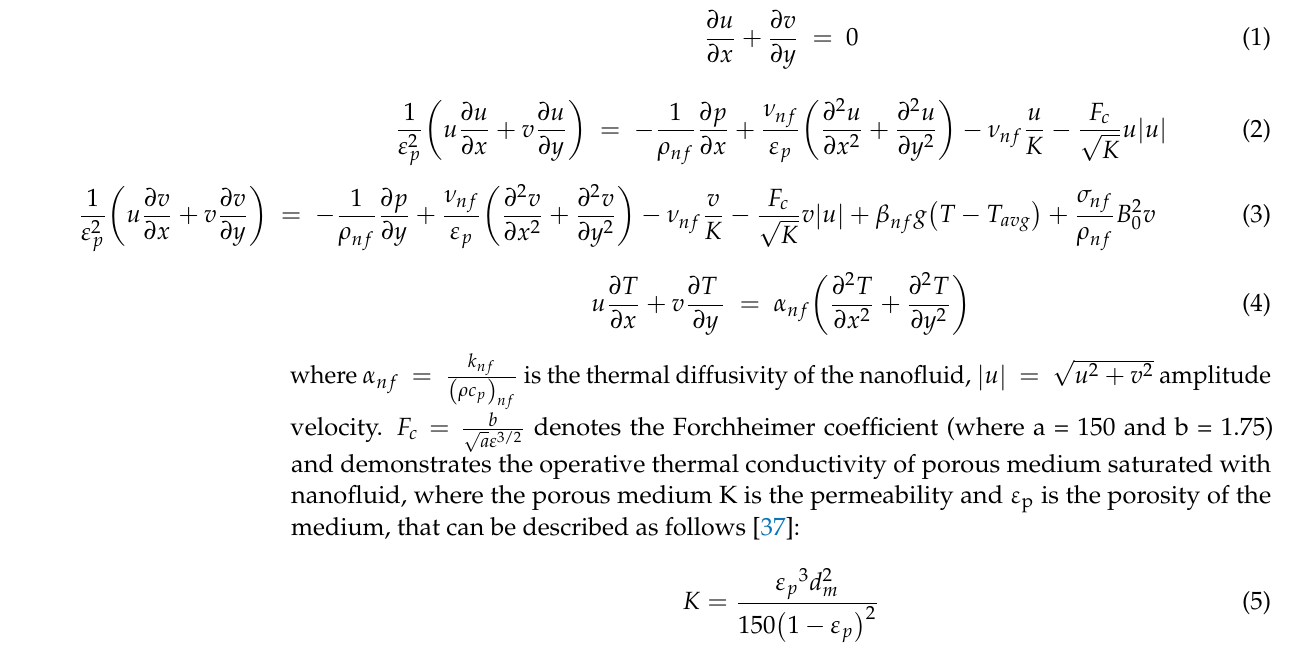
Table 1. Thermophysical properties of the nanoparticles and the fluid (Ag/MgO/water (50:50)) [37]. Physical Properties Water Ag